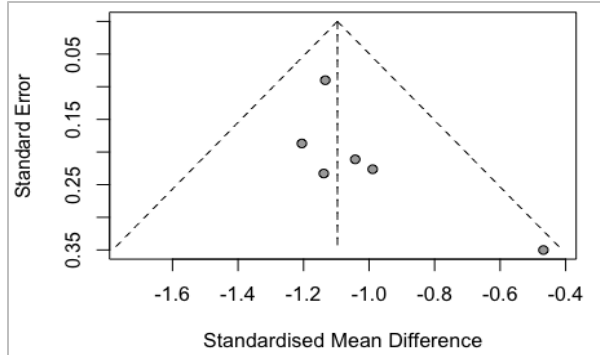
Figure A12 . The funnel plot does not reveal any clear presence of publication or other bias, but the number of studies is notably quite small for HC versus MCI_AD.